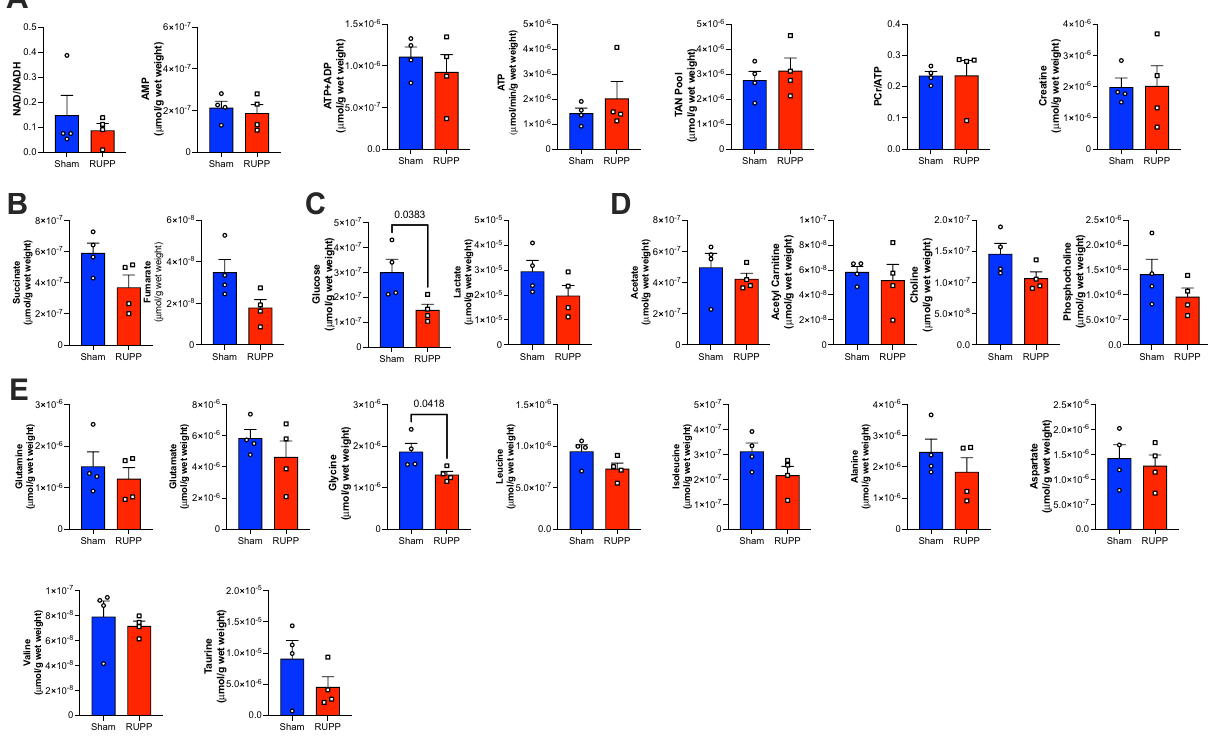
Figure 5. Impact of RUPP on fetal cardiac metabolism. Metabolite concentrations are grouped into ( A ) Redox and Energetics ( B ) TCA Cycle ( C ) Carbohydrate metabolism ( D ) Lipid metabolism ( E ) Amino acid metabolism. Two group comparison was carried out using the student T test (normally distributed data) or Mann–Whitney U test (non-normally distributed data: NAD/NADH, valine, ATP, Taurine, PCr/ATP) TAN- total adenine nucleotide pool (AMP + ADP + ATP). n = 4/group. PCr-phosphocreatine. P values < 0.05 shown in individual